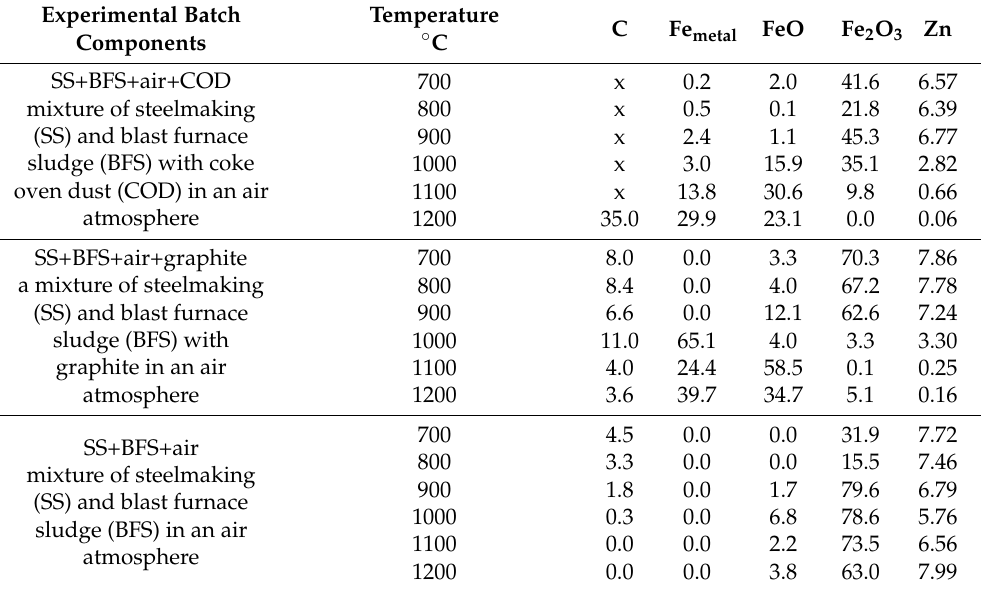
x—the element C was not detected. Table 5. The chemical composition of the experiments carried out for mixture of steelmaking and blast furnace sludge [wt.%] XRFS analysis.